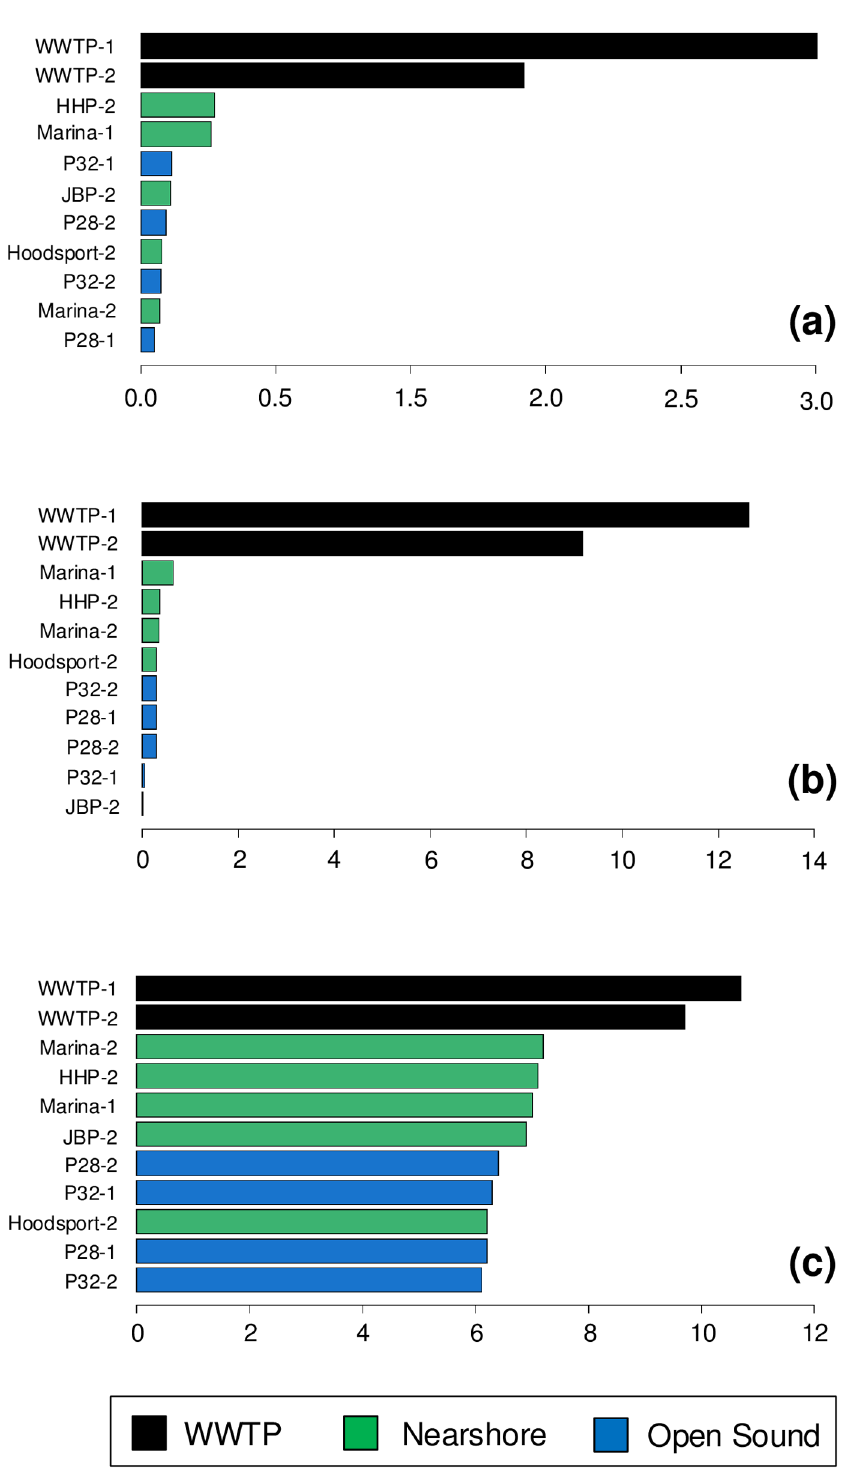
Fig 5. Potential anthropogenic determinants and detoxification systems related to public health. (a) Percent of MEGAN LCA family taxonomic rank assignments for sewage influent bacterial families. (b) Percent of MEGAN taxonomic assignments for 28 human bacterial pathogenic genera. (c) Combined percentage of reads assigned to antibiotic resistance determinant elements, polycyclic aromatic hydrocarbon (PAH) degradation and detoxification systems Hidden Markov